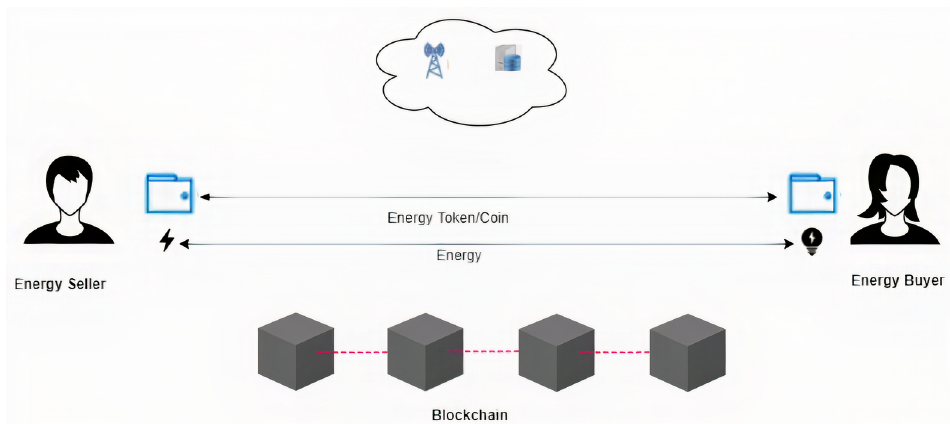
Figure 2. Proposed blockchain